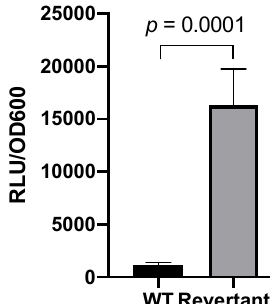
Figure 3. Promoter activity of the mexEF-oprN operon in P. putida KT2440 in presence of Bip . The transcriptional gene fusion using the lux reporter was generated by cloning the promoter region of mexEF-oprN into the BBR1-MCS5- lux plasmid. For the luciferase assay, overnight cultures of the transformed strains were grown in KB in presence of 0.5 mM Bip and 30 μg/mL gentamicin. After 8 h of growth, the relative light units (RLU) were normalized against the OD 600 of the cultures. Experiments were performed a minimum of three times.